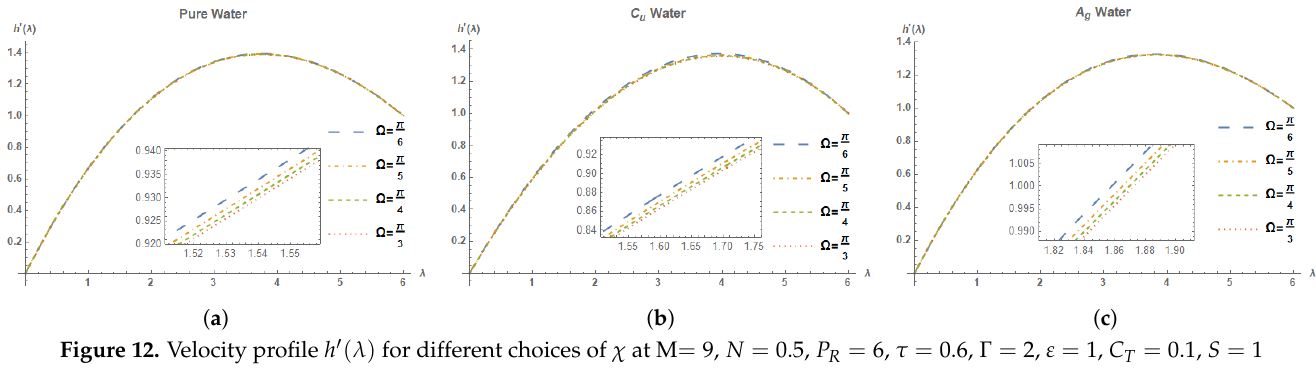
Figure 11. Velocity profile h (cid:48) ( λ ) for different choices of m at M = 9, N = 0.5, P R = 6, χ = π S = 1 showing their exciting nature. ( a ) pure-water. ( b ) Cu-water. ( c ) Ag-water.